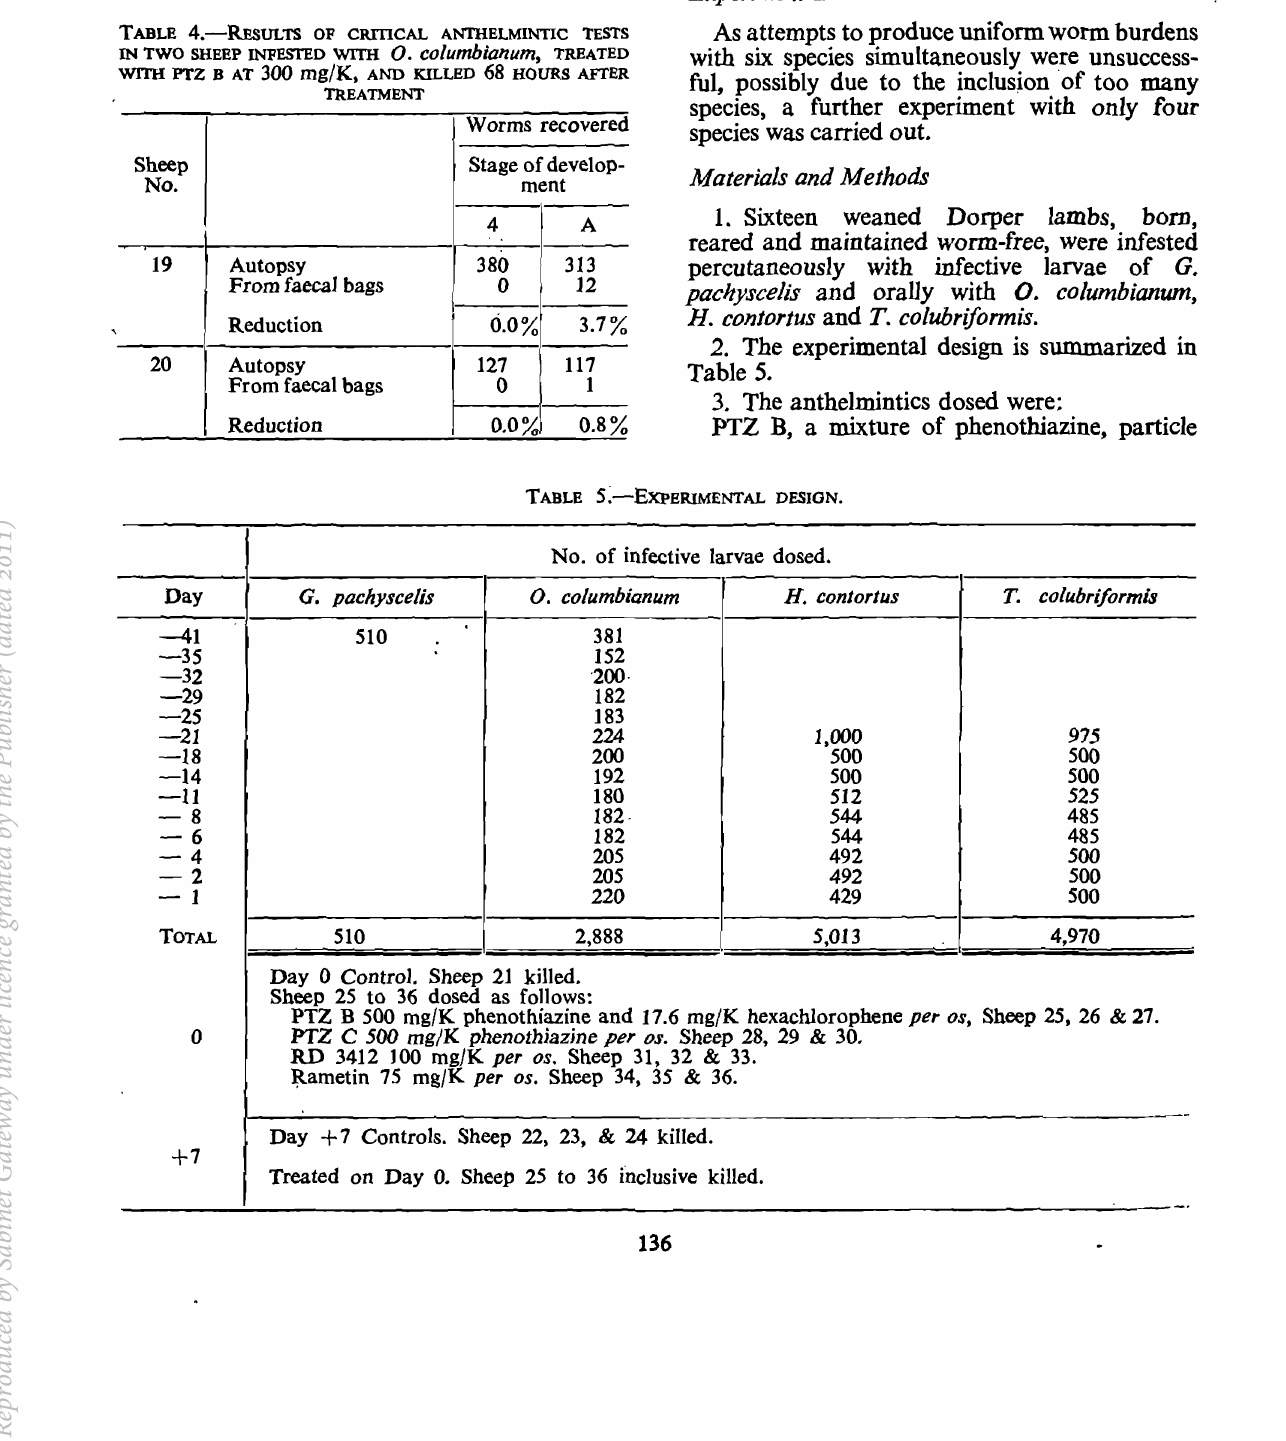
TABLE 4.-REsULTS OF CRTIlCAL ANTHELMINTIC TESTS IN TWO SHEEP INFESTED WITH O. columbianum, TREATED WITH PTZ B AT 300 mg/K, AND KILLED 68 HOURS AFTER TREATMENT Worms recovered Sheep Stage of develop-